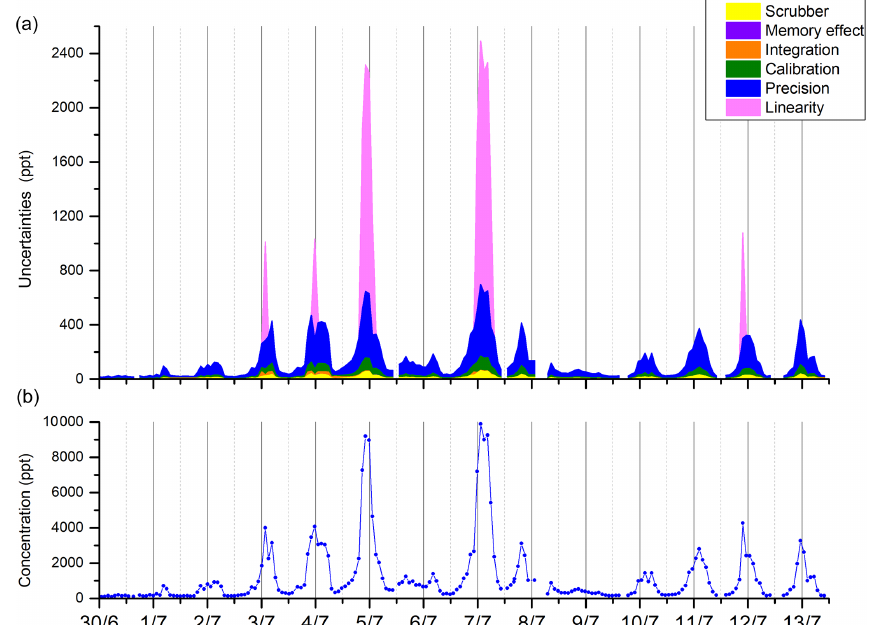
Figure 8. Repartitioning of uncertainties ( k = 2) for the six terms considered (precision, calibration, integration, memory effect, scrubber, and linearity) (a) and the concentration of β -pinene during the LANDEX episode 1 field campaign (b) .